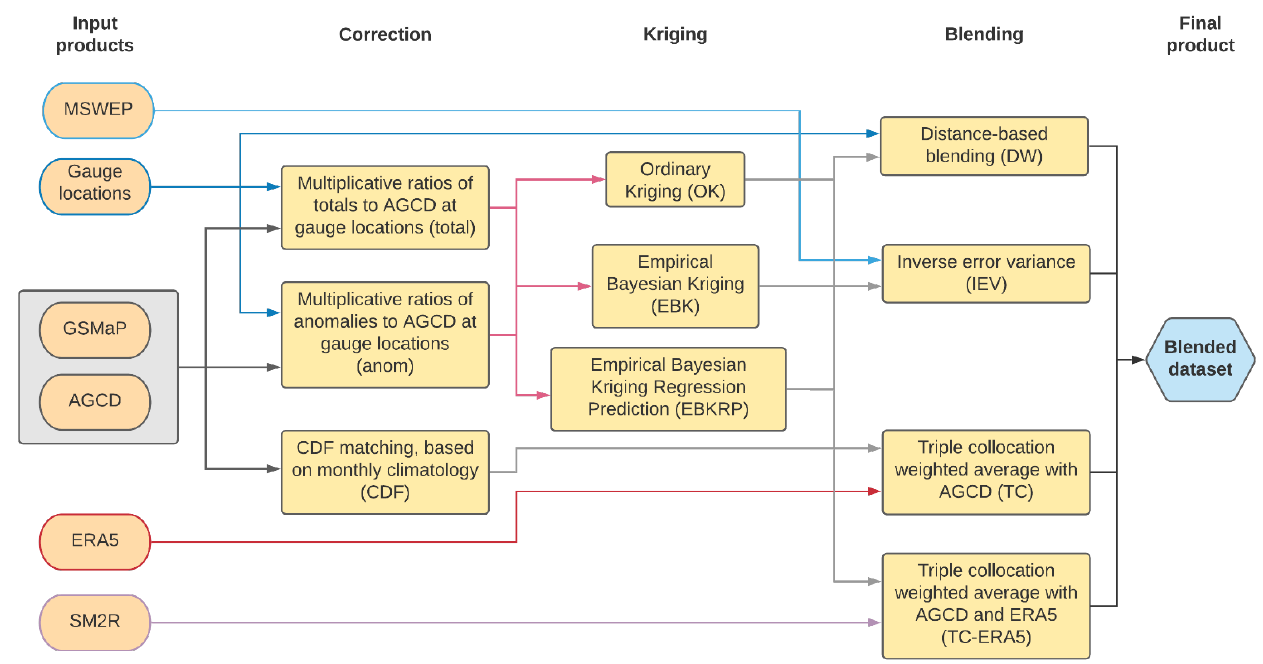
Figure 2. Datasets and processes involved in creating the corrected and blended